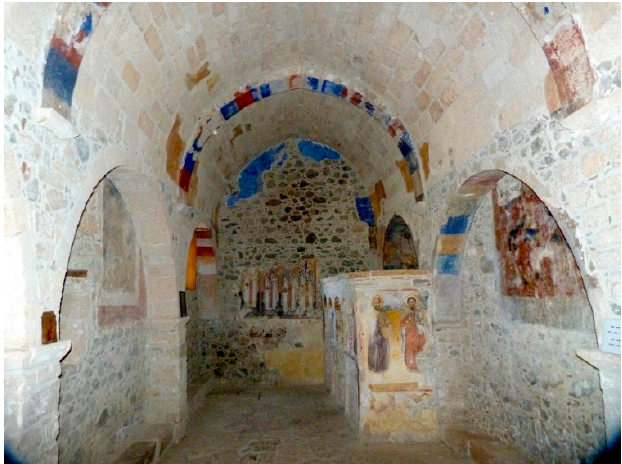
Figure 31. Interior of the Church of Hagios Georgios Katholikos, Paliachora (Aegina), end of the 14th c.